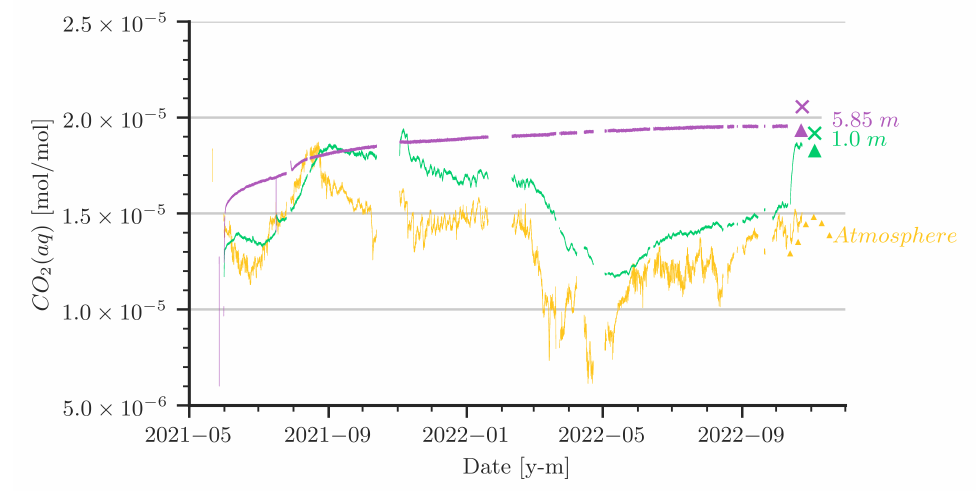
Figure 6. Values of aqueous CO 2 concentrations (CO 2 (aq)) from sensors at various depths are shown by the line plots. The sensor at 5.85 m depth was damaged during sampling in October 2022 and was therefore removed. CO 2 (aq) concentration calculated from water samples and from the control sensors are indicated with an ‘x’ mark and triangles,